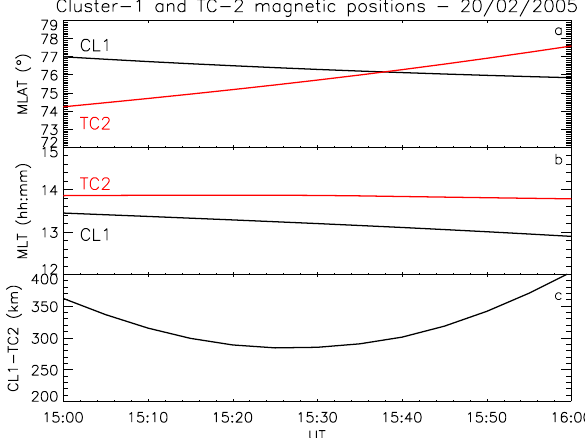
Fig. 1. Cluster-1 (in black) and TC-2 (in red) positions for the period 15:00–16:00UT. (a) Magnetic (AACGM) latitude (MLAT). (b) Magnetic local time (MLT). (c) Transverse distance between Cluster-1 and TC-2, mapped at the ionospheric altitude